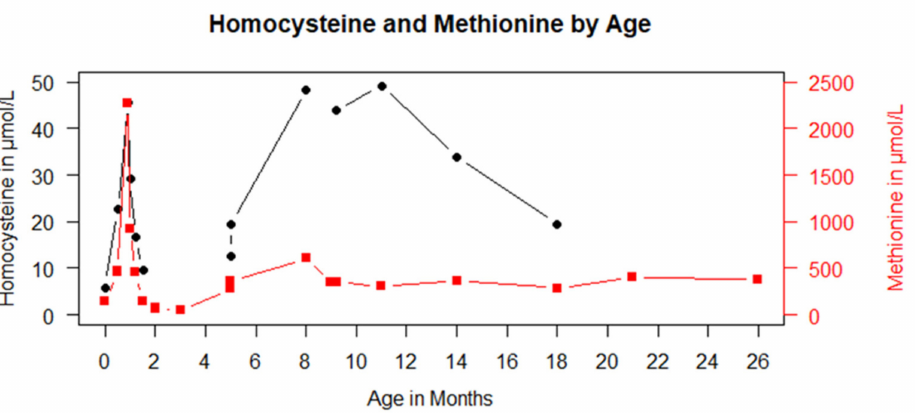
Figure 1. Methionine (red) and total homocysteine (black) concentrations are plotted against age in months.